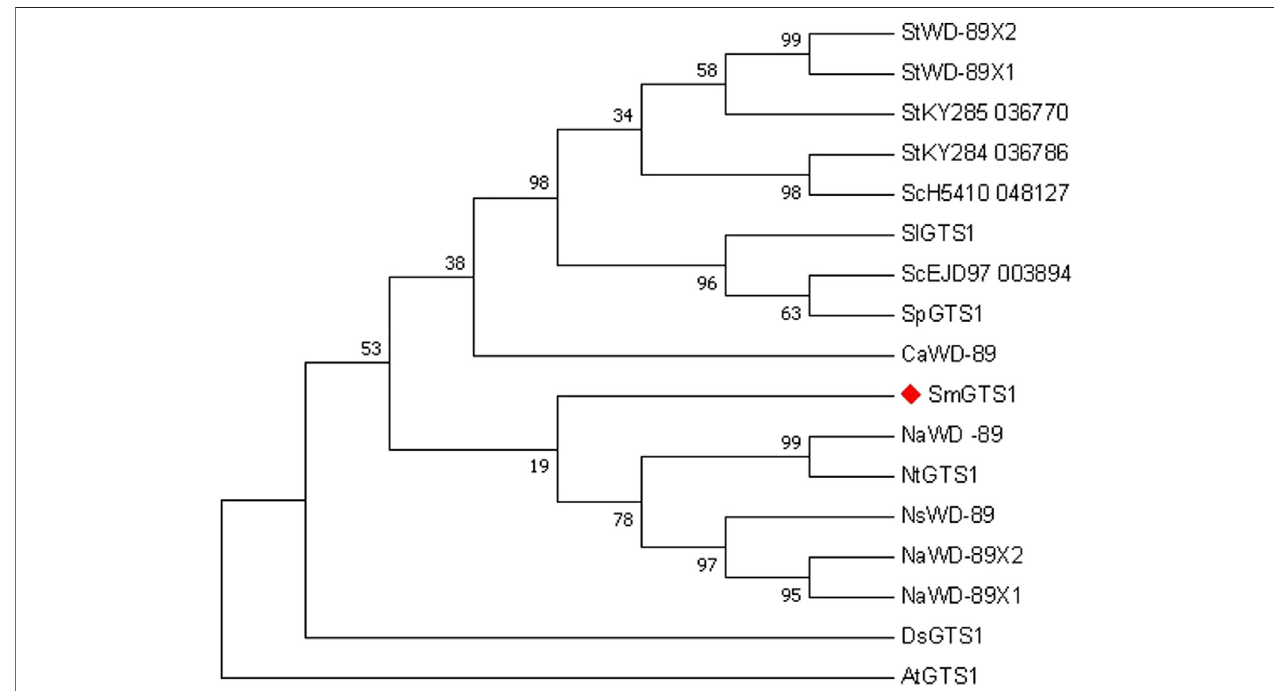
FIGURE5| PhylogeneticanalysisofSmGTS1byMaximumLikelihoodmethod.Thepercentageofreplicatetreesinwhichtheassociatedtaxaclusteredtogetherin the bootstrap test (1,000 bootstrap replications) are shown next to the branches. Protein name: the initials of the species name, and the protein features. The SmGTS1 was marked with a red